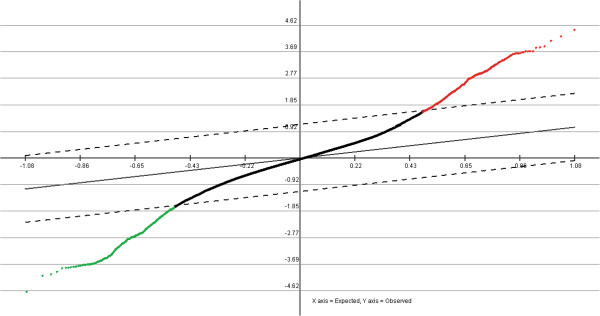
Significance Analysis of Microarrays (SAM) graph for MCF-7DOX2-12and MCF-7CC112cells. Red or green points denote genes with significant over- or under-expression in MCF-7DOX2-12 cells compared to MCF-7CC12 cells, while black points represent genes that do not show altered expression.